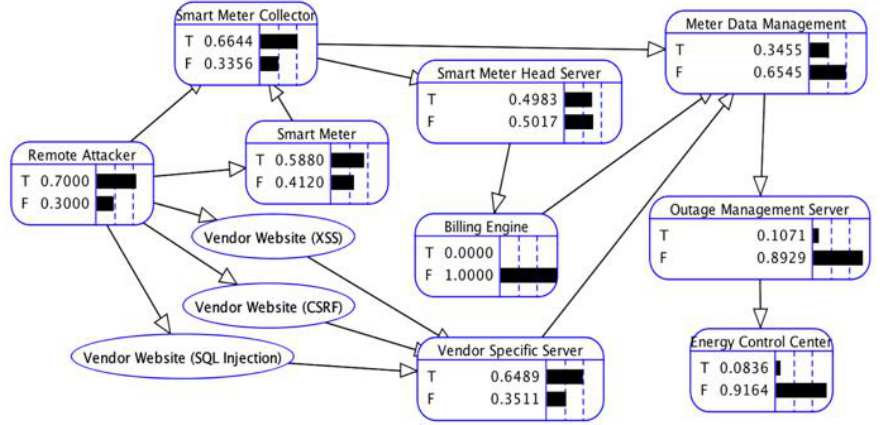
Figure 9. Probability distributions when the probability of a remote attacker to attack is 0.70. Electronics 2018 , 7 , x FOR PEER REVIEW